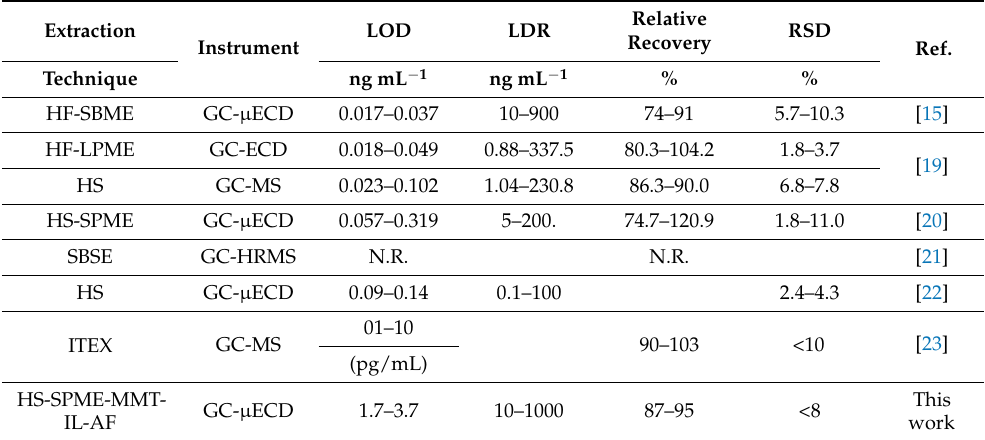
Table 5. Developed methods for analyzing THMs in drinking water by using microextraction techniques as sample preparation and greener